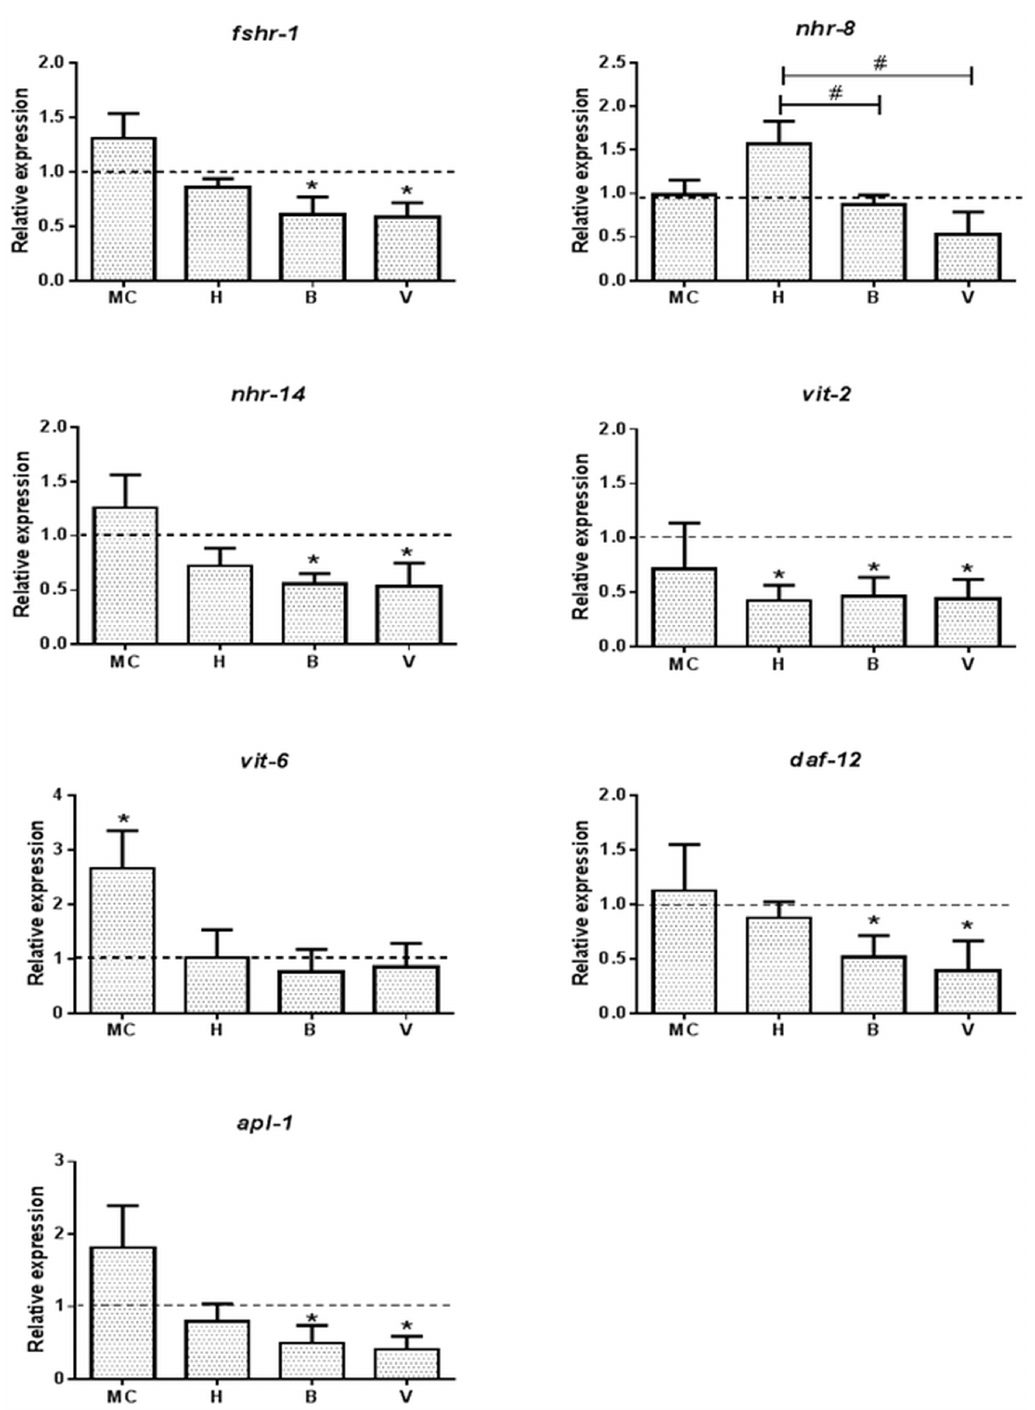
Fig 5. Effect of metals exposure on nuclear hormone receptors and developmental genes in C . elegans . C . elegans treated with the metal cocktail (MC) or waters from Lake Hornträsket (H) and Vombäcken stream at Björn å s (B) and the exit to Vindelälven (V) were analyzed for the expression of genes associated with hormone receptors ( fshr-1 , nhr-8 and nhr-14) and development ( vit-2 , daf-12 , and apl-1) were tested using qRT-PCR. One way analysis of variance (ANOVA) followed by Tukey ’ s post-test was used for multiple group comparison where * refers to p < 0.01 as compared to control whereas # represents significant differences in between the sites H, B and V. The dotted line represents the expression level normalized to that of the control (K-medium prepared with Milli-Q water).